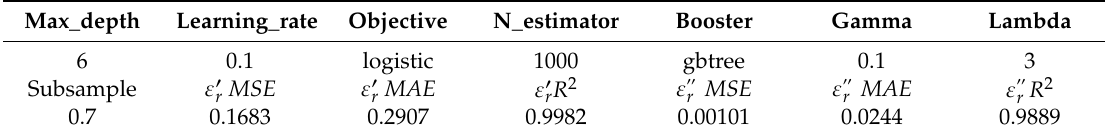
Table 2. Parameters of Extreme Gradient Boosting (XGBoost) model.